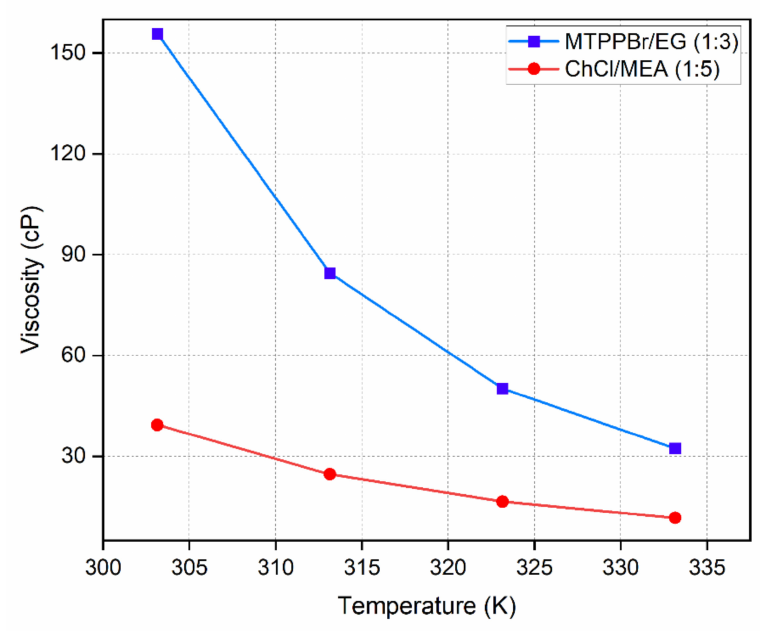
Figure 8. Viscosity of DESs as a function of